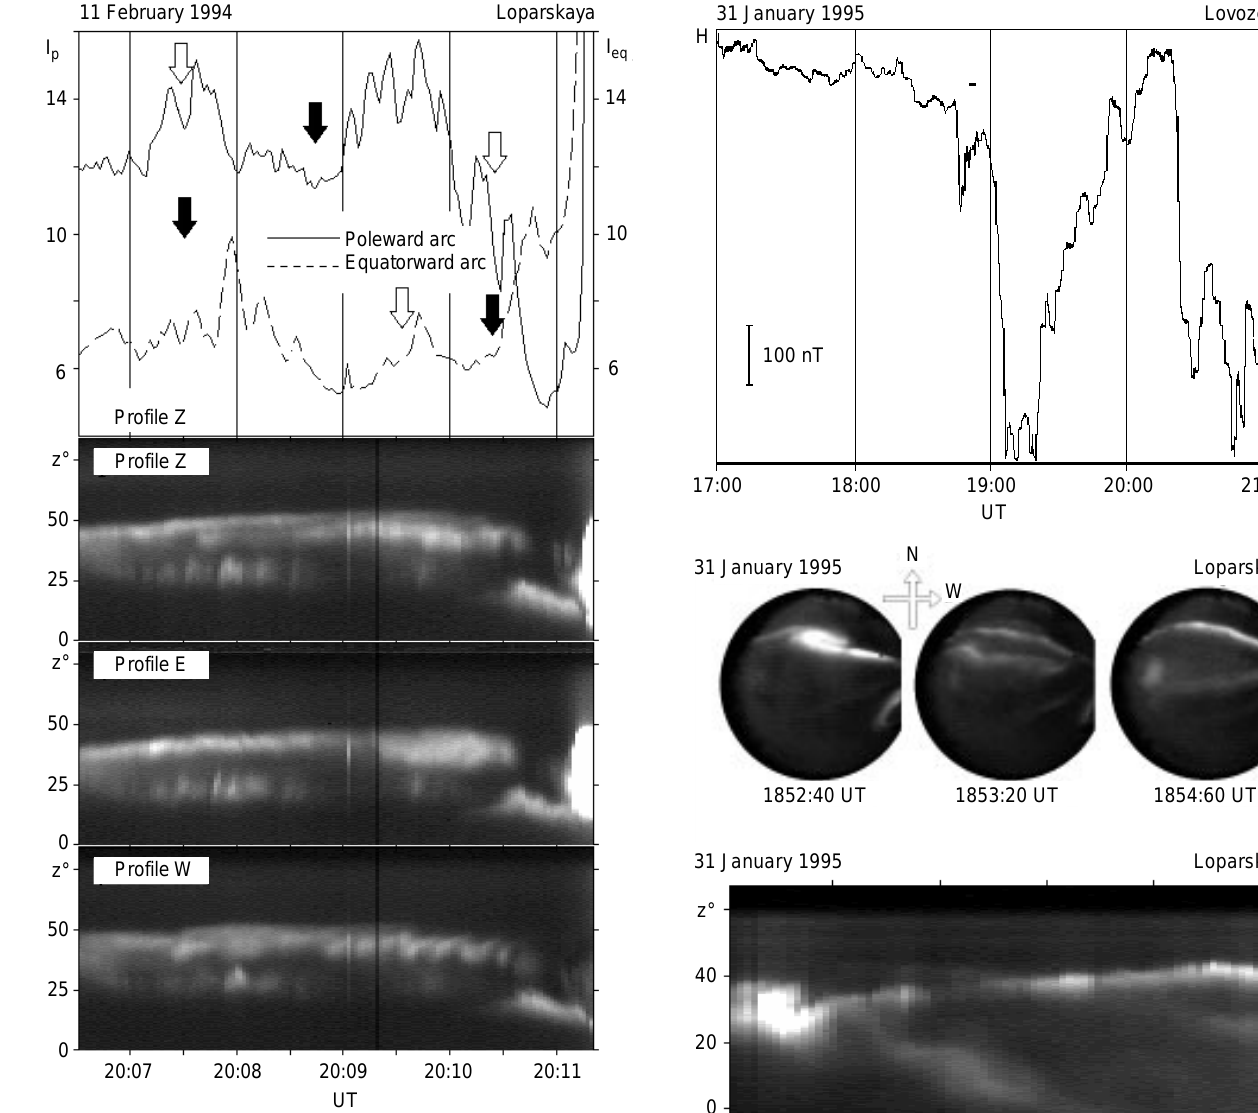
Fig. 5. The same as in Fig. 3 for the MAAS interval on 11 February 1994